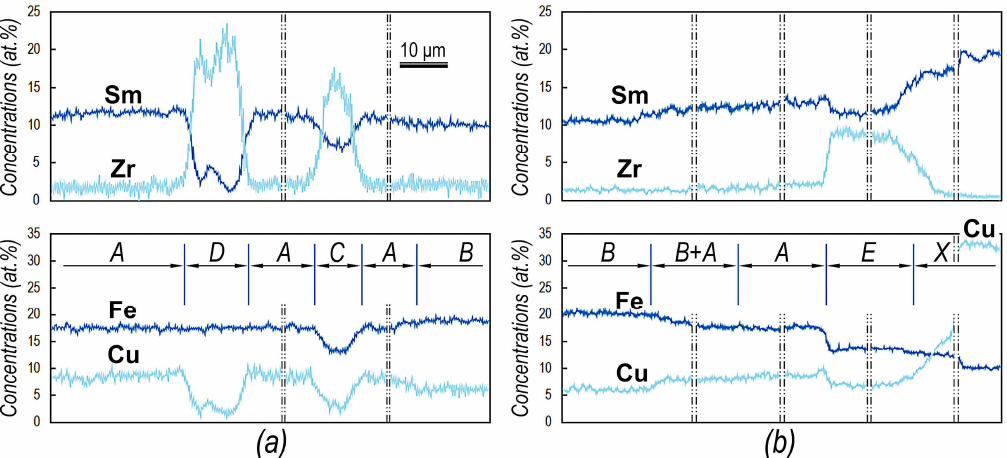
Figure 6. Element concentration distributions for structural components of high-coercivity pseudo-single-crystal ( a ) Sm 0.85 Zr 0.15 (Co 0.702 Cu 0.088 Fe 0.210 ) 6.6 and ( b ) Sm 0.87 Zr 0.13 (Co 0.690 Cu 0.070 Fe 0.240 ) 6.5 samples (SEM, EPMA).